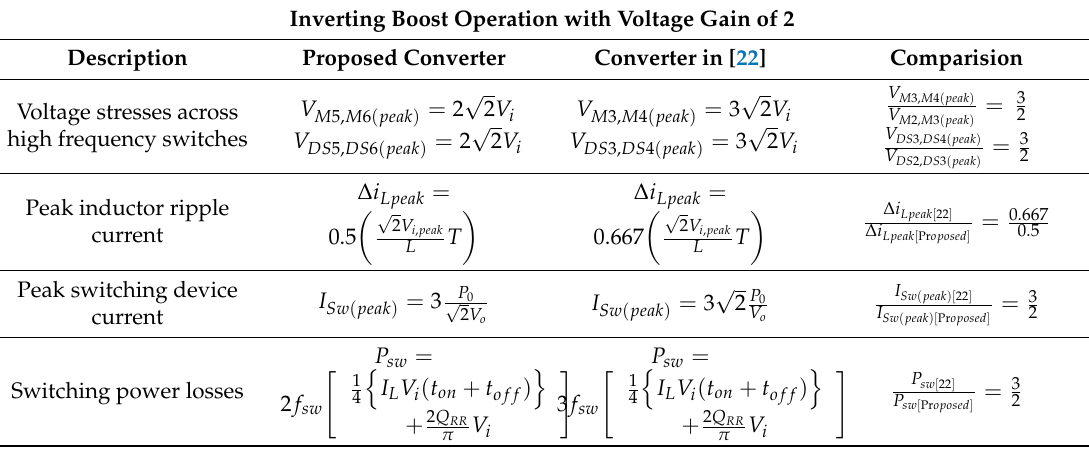
Table 4. Comparison of performance parameters in boost